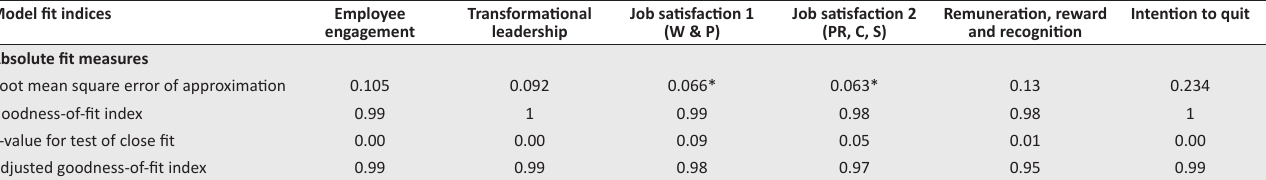
TABLE 4: Confirmatory factor analysis of the measurement models.